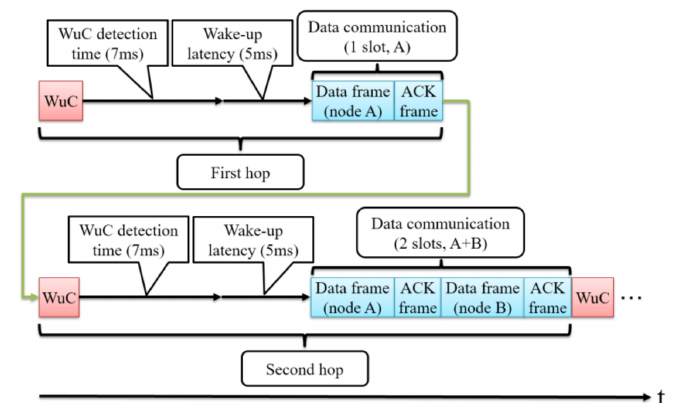
Figure 3. Time-sequence diagram of the data collection